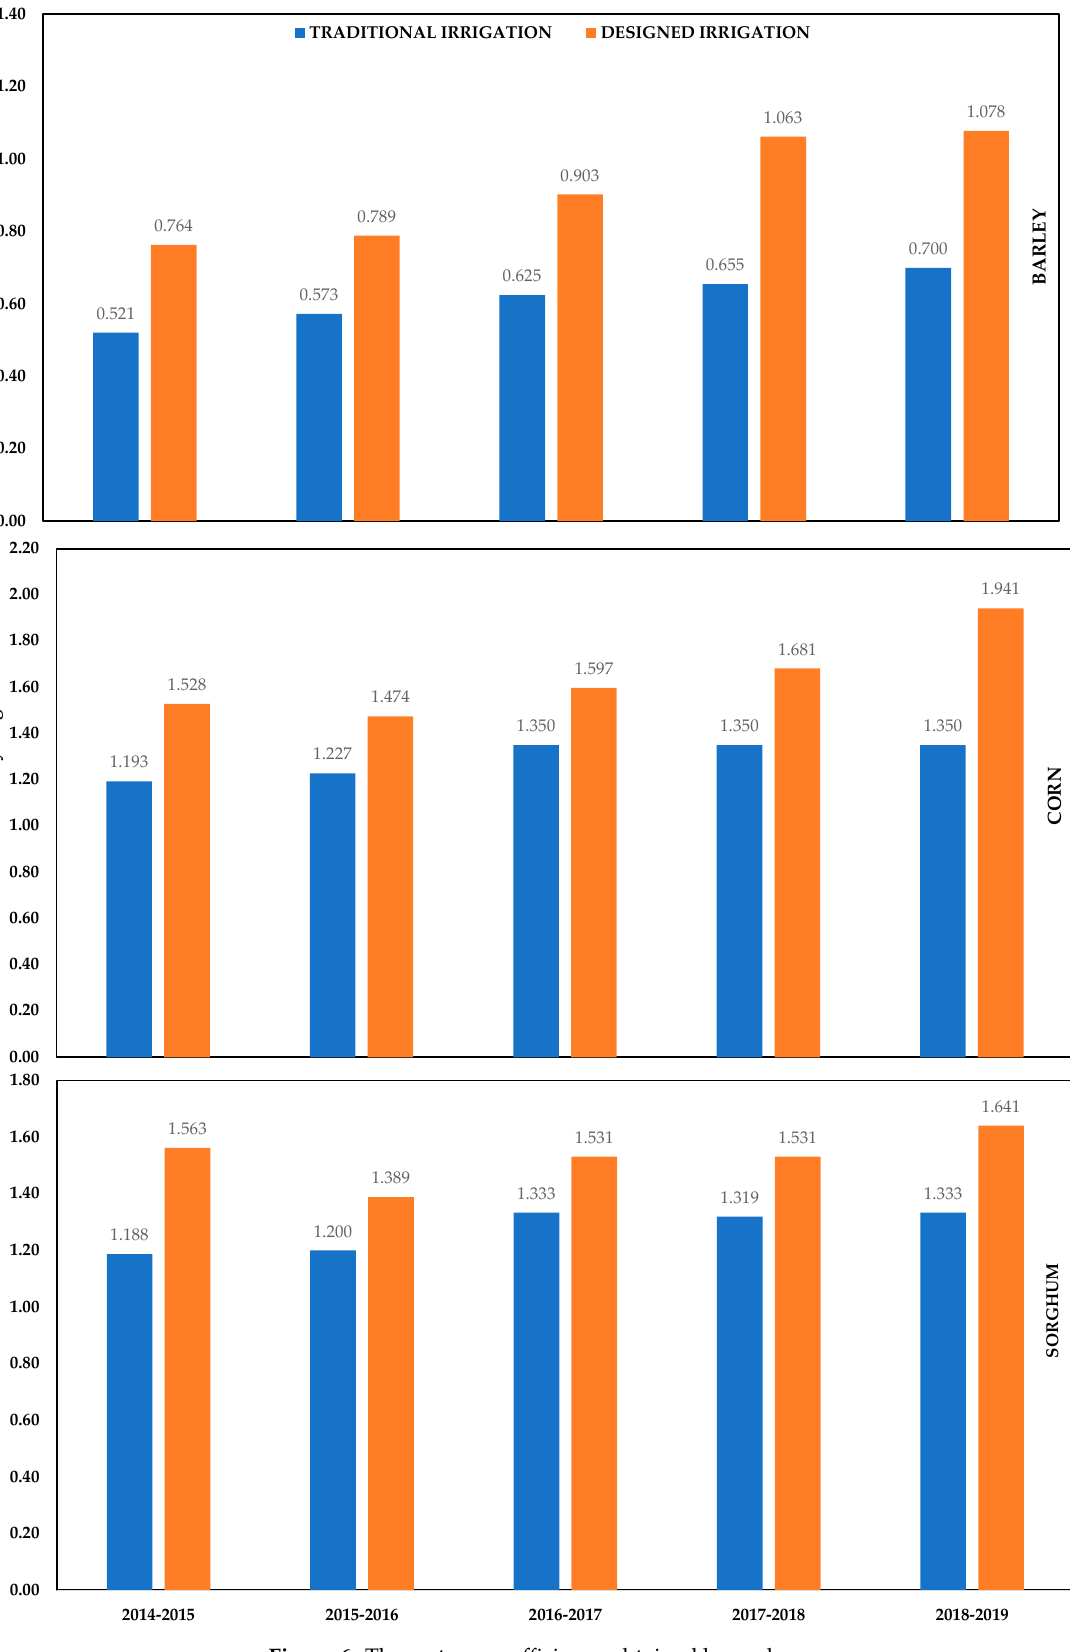
Figure 6. The water-use efficiency obtained by cycle.